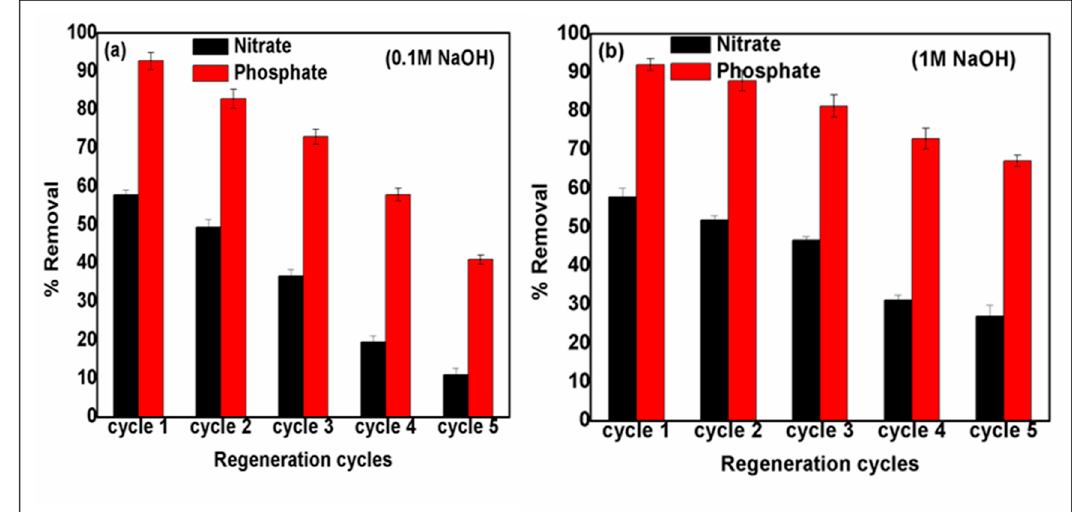
Figure 8. Reusability performance of B5MgAl after regeneration at ( a ) 0.1M NaOH and ( b ) 1M NaOH.